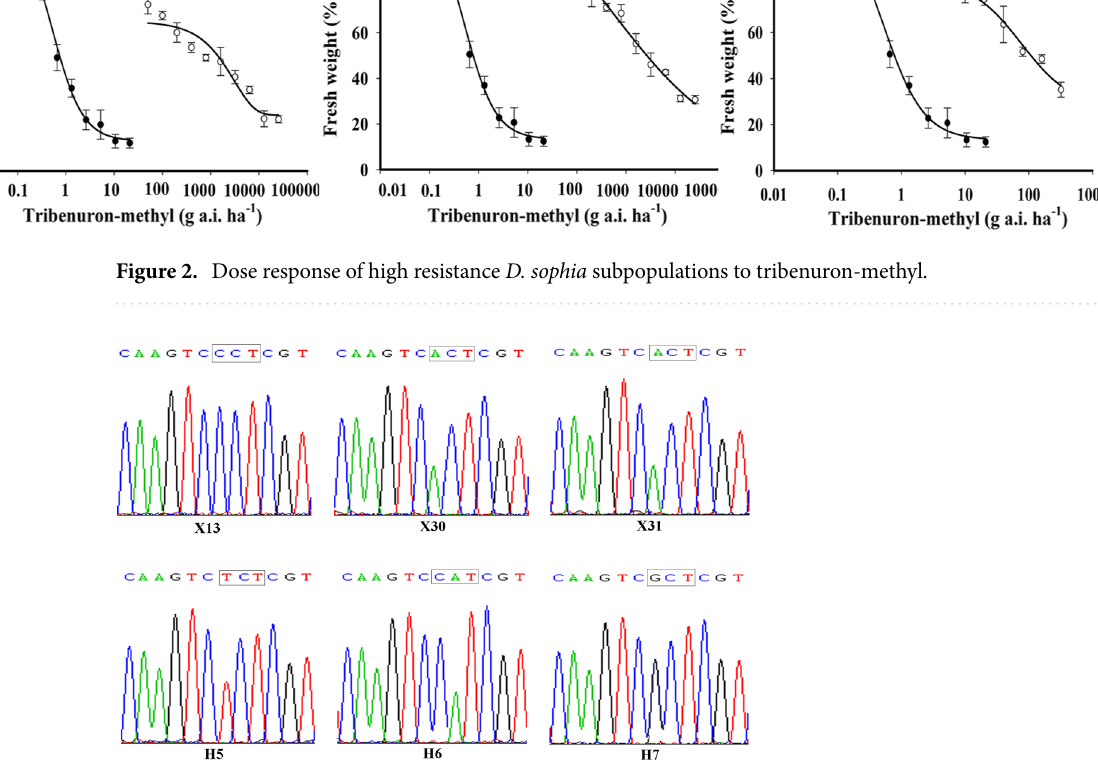
Figure 3. Mutation type of Pro197 in ALS1 of the high resistant populations of D. sophia